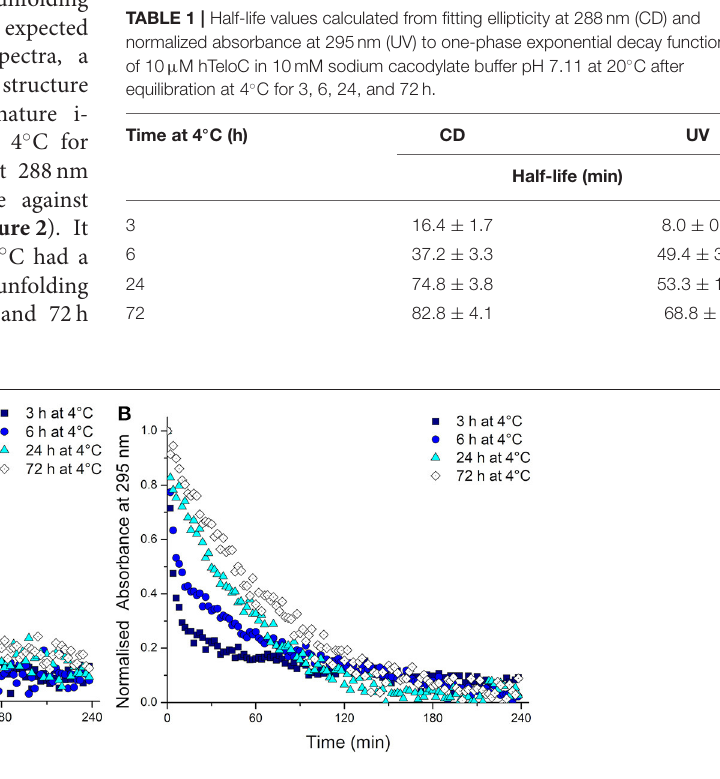
FIGURE 2 | (A) Ellipticity at 288nm and (B) normalized absorbance at 295nm of 10 µ M hTeloC in 10mM sodium cacodylate buffer pH 7.11 measured every 2min after storage at 4 ◦ C for the indicated time.